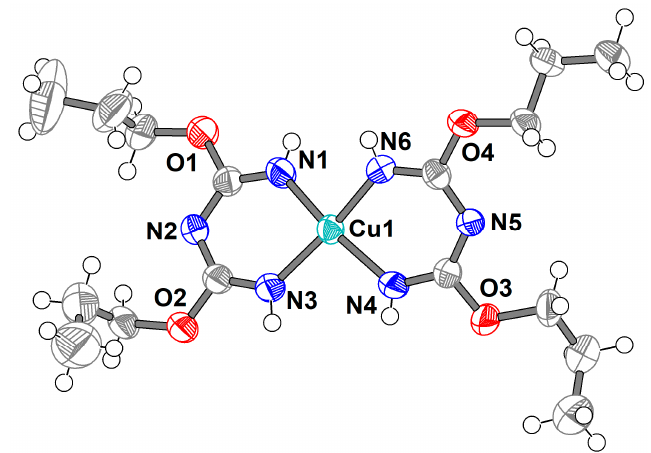
Figure 1. Molecular structure of 3 with atom numbering where non-hydrogen atoms are shown as 50% ellipsoids.